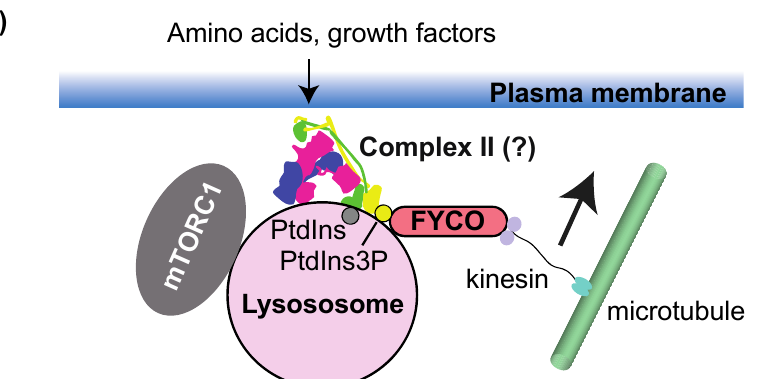
Figure 4. VPS34 complex regulation by the ULK1 complex and mTORC1. ( A ) The ULK1 complex acts as a positive regulator of complex I during starvation, whereas mTORC1 acts as a negative regulator in nutrient-replete conditions. Their phosphorylation positions are indicated in the schematic structure of complex I. Green dots: activating phosphorylation by the ULK1 complex; red dots: inhibiting phosphorylation by mTORC1. ( B ) Left: VPS34 (or, putatively, complex II) acts as a positive regulator of mTORC1 in amino acid-replete conditions. Amino acids activate VPS34 to synthesize PtdIns(3)P, which activates PLD1. Phosphatidic acid (PA), the PLD1 product, binds to mTOR to activate it. Right: After long-term starvation, lysosomes are regenerated by autophagic lysosomal regulation (ALR). Then, accumulated autophagy sub- strates in autolysosomes are degraded, and amino acids are regenerated. This activates mTORC1 to phosphorylate UVRAG, the complex II-specific subunit, and activate complex II. This activity is necessary for the scission step of ALR, in